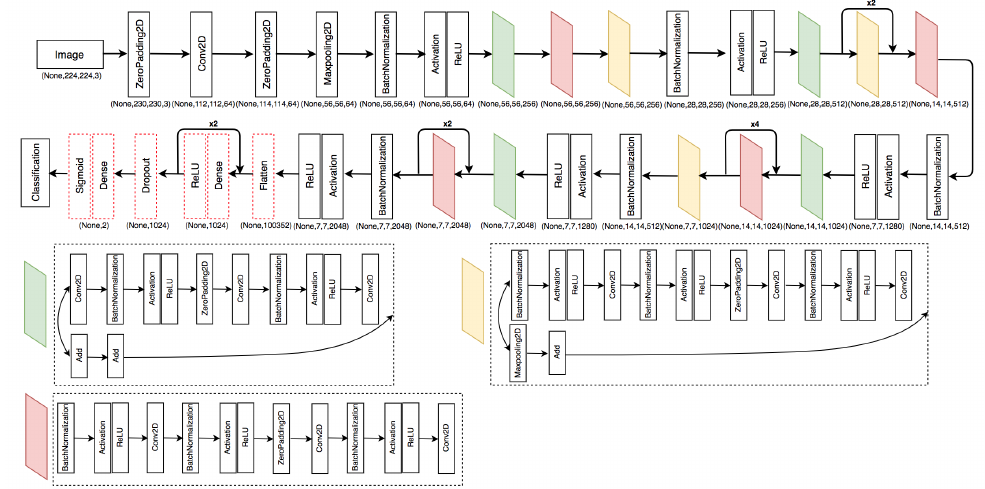
Figure 12. The network architecture of the proposed method 2 developed from